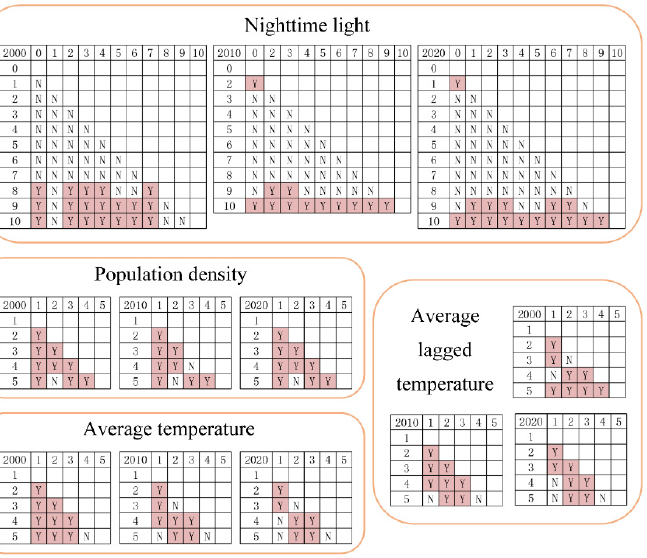
Figure 10. The risk detector results of nighttime light factor, population density factor, average tem ‐ perature factor, and average lagged temperature factor in 2000, 2010, and 2020. temperature factor, and average lagged temperature factor in 2000, 2010, and